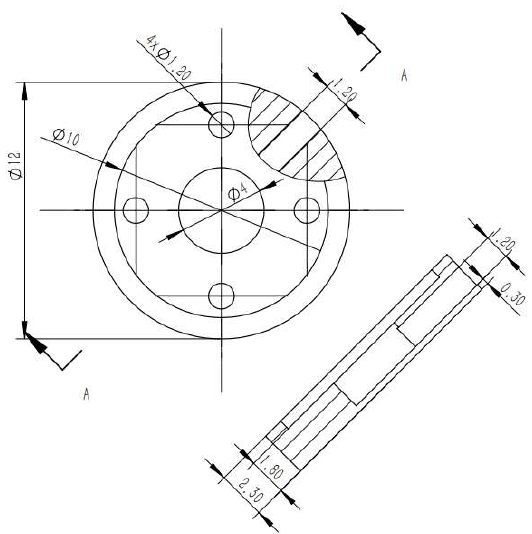
Figure 4. Diagram and dimensions of millirobot pedestal in millimeters.